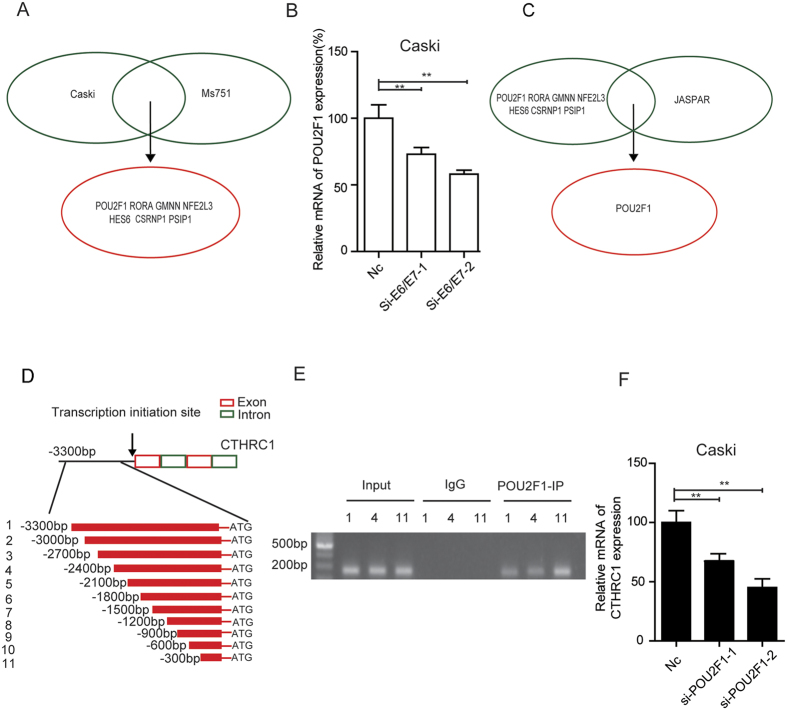
POU2F1 can regulate the exprssion of CTHRC1.(A) Seven transcription factors were significantly down-regulated in Caski and Ms751 cells with silencing of E6/E7 as compared with control cells (fold change > 3 and P < 0.05). (B) Silencing of E6/E7 in Caski significantly decreased POU2F1 expression, detected by RT-PCR and normalized with 18S expression. (C) Transcription factor POU2F1 maybe the target gene combined the transcription profiling microarray and online tools. (D) Schematic structure of CTHRC1 promoter. The red and green rectangles indicate exon and intron of CTHRC1 respectively. The zone between black lines represent the primers used in ChIP analysis. (E) A ChIP assay was performed using chromatin from Caski cells. (F) The expression of CTHRC1 was decreased with silencing of POU2F1 in Caski cells, detected by RT-PCR and normalized with 18S expression.